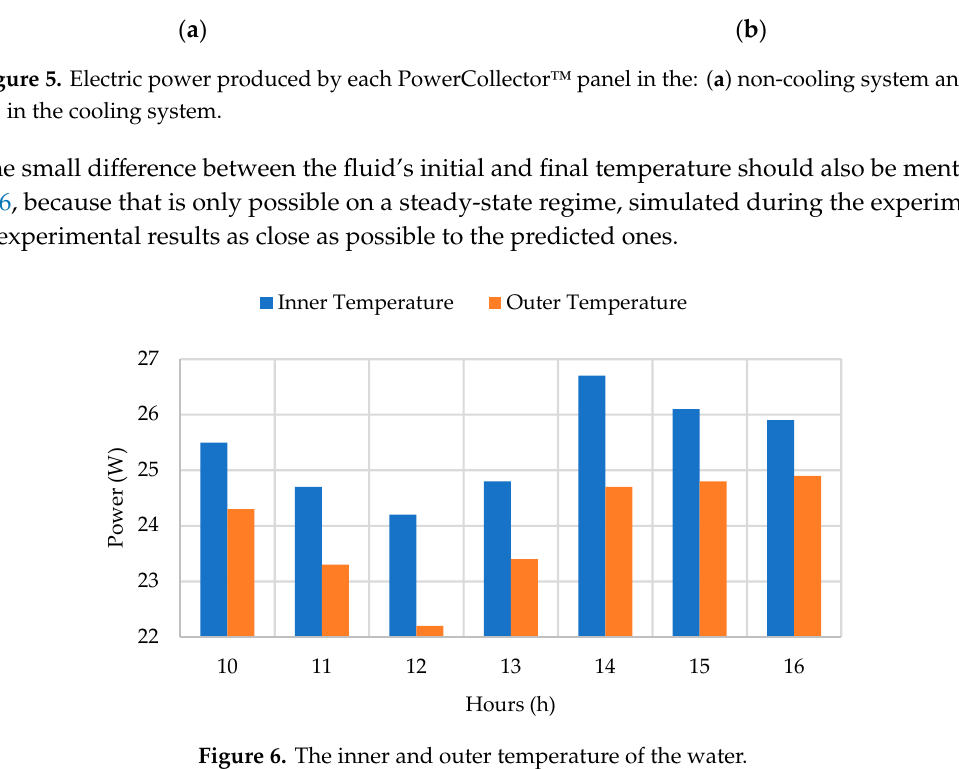
Figure 6. The inner and outer temperature of the water.